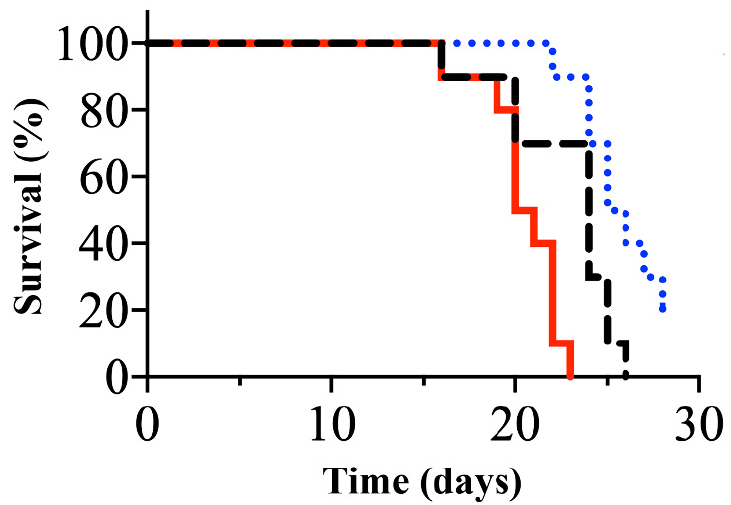
Figure 4. Kaplan-Meier survival curves of nude mice after abdominal inoculation with ES-2/T-42 cells alone (black dashed line), ES-2/T-42 cells together with sialidase (red solid line), and ES-2/T-42 cells together with N -acetyl-2,3-dehydro-2-deoxyneuraminic acid (NADNA), a sialidase inhibitor, (dotted blue line). Ten mice were used in each group. Kaplan-Meier method log rank (Mantel-Cox) test. p < 0.0001.